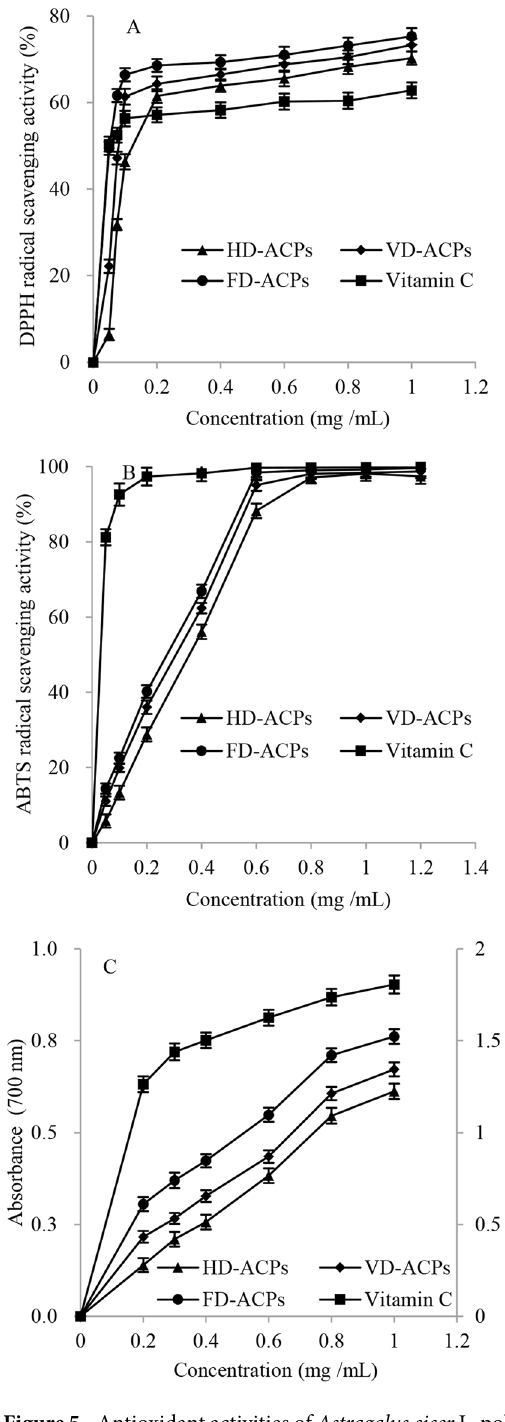
Figure 5. Antioxidant activities of Astragalus cicer L. polysaccharides dried by three methods: HD-ACPs, dried by hot air drying method; VD-ACPs dried by vacuum drying method; FD-ACPs dried by freeze drying